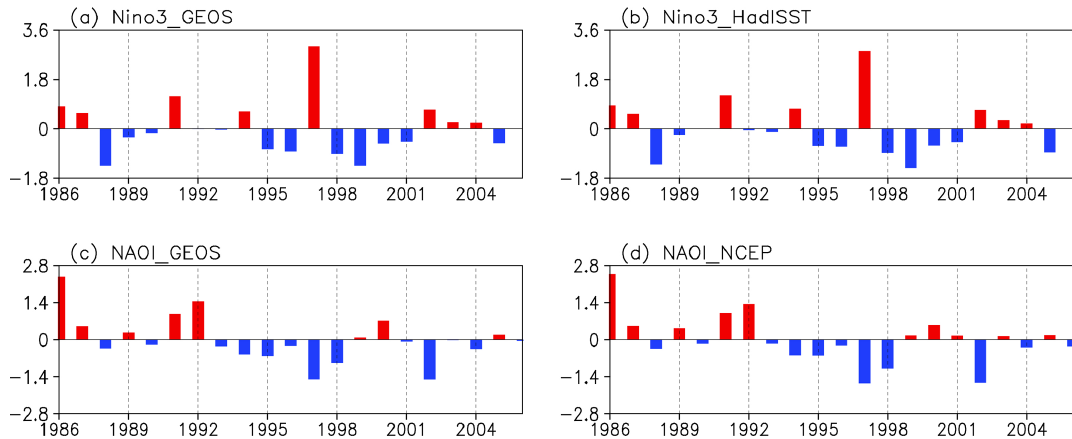
Figure 1. (a) Time series of the Niño3 index based on the GEOS-4 input skin temperature data for 1986–2006 ( ◦ C). Panel (b) is similar to (a) but based on HadISST. (c) Time series of the NAO index based on the GEOS-4 input sea level pressure. Panel (d) is similar to (c) but based on the NCEP/NCAR